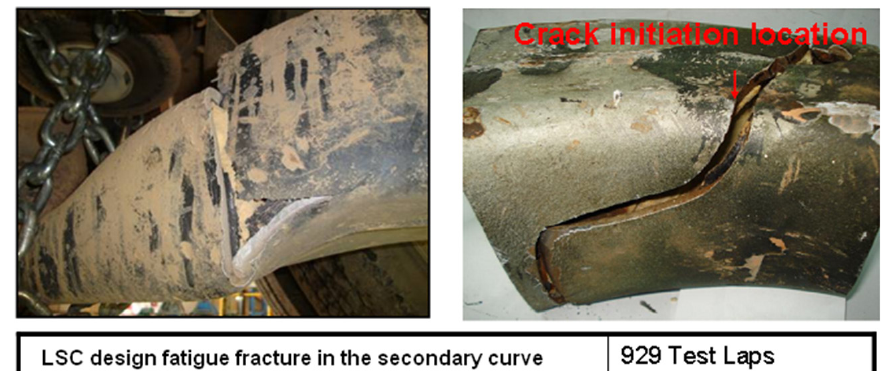
Figure 7. Fatigue failure event during the standard durability track testing